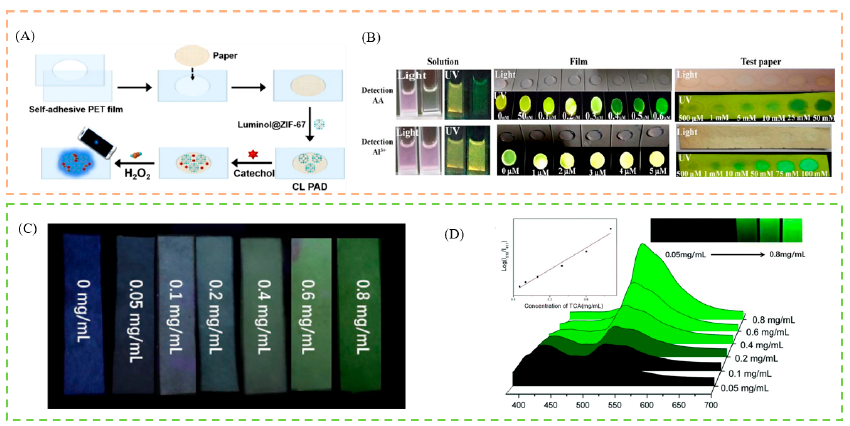
Figure 4. ( A ) Schematic description of cobalt–imidazole metal–organic framework loaded with lu- minol, for paper-based chemiluminescence detection of catechol with the use of a smartphone. ( B ) Schematic illustration of application for AA and Al 3+ detection by FL@UiO-67 solution, FL@UiO-67 film, FL@UiO-67 test paper. ( C ) Schematic illustration of application for TCA detection by test strips. ( D ) Schematic illustration of emission spectra of the FS@1 in the presence of different concentrations of TCA in real urine. Reproduced with permission from [121–123]. Copyright 2021, Springer; 2021, Elsevier; and 2019, Royal Society of Chemistry.